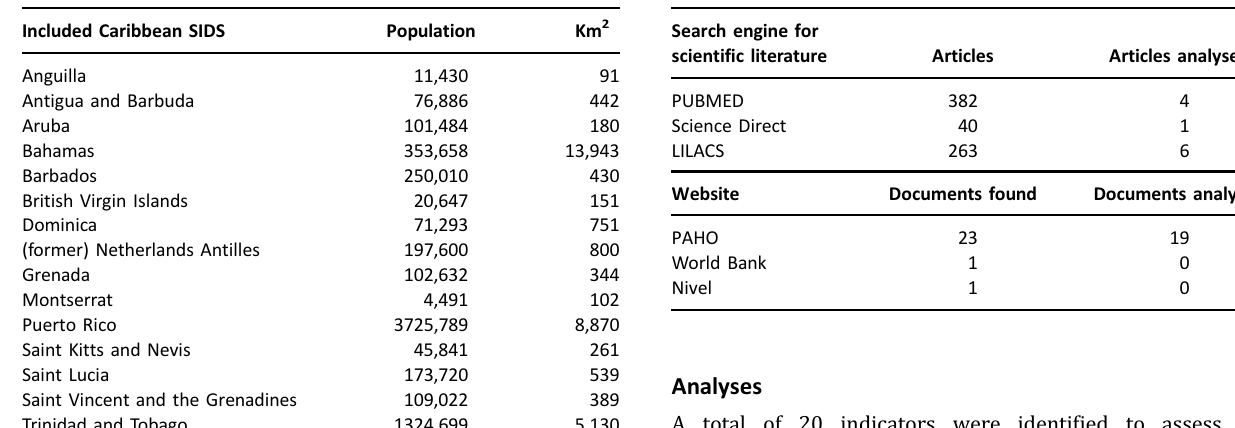
Table 1 . Included islands. Table 2 . Document